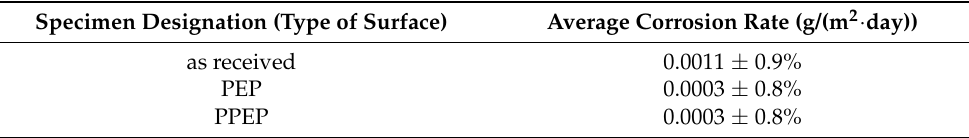
Table 7. Average corrosion rates calculated from mass losses during the exposure